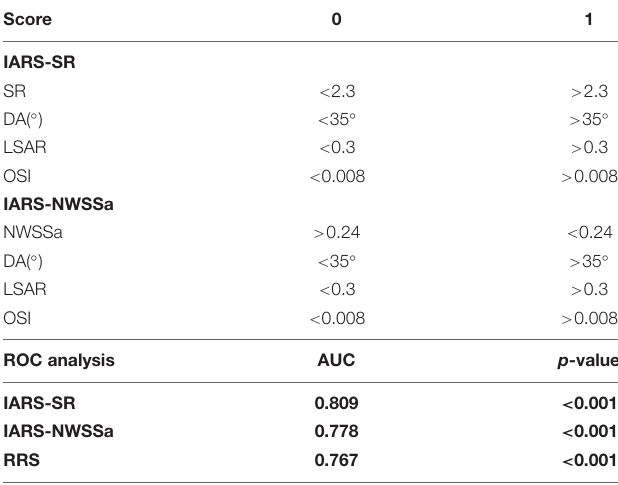
TABLE 4 | Intracranial Aneurysms Rupture Score (IARS) and result of ROC of three